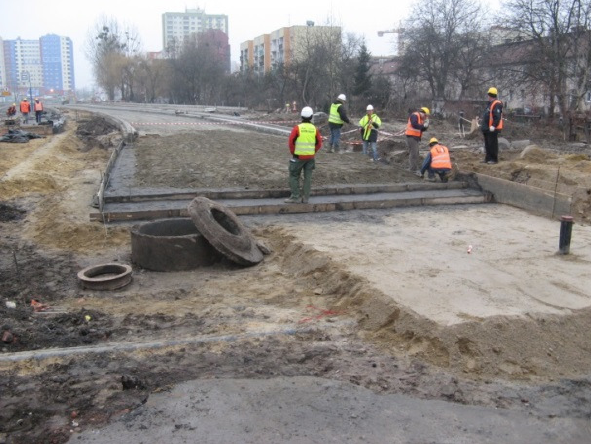
Fig. 5. Works performed in advance (photo J. Chrobok)